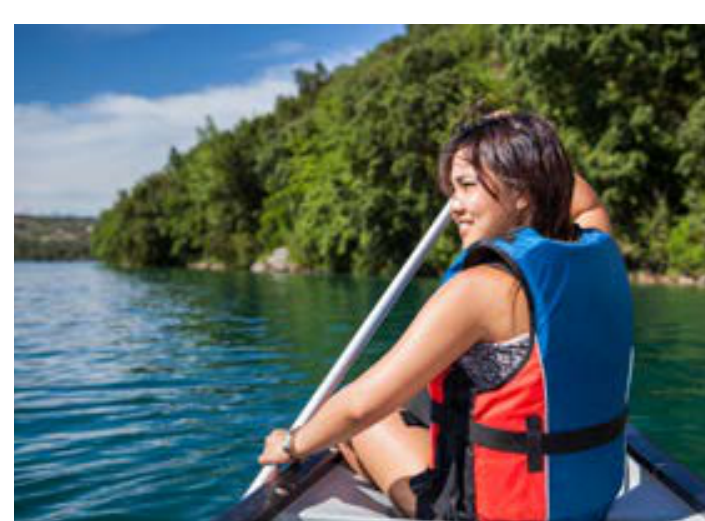
In fact, there is strong evidence that Canadians continue to cherish their national parks. Polling over decades has consistently shown that national parks are considered one of the top four symbols of Canadian identity. 13 Parks Canada’s own research shows that unspoiled nature and beautiful scenery are the main reasons why urban residents are attracted to our national parks.